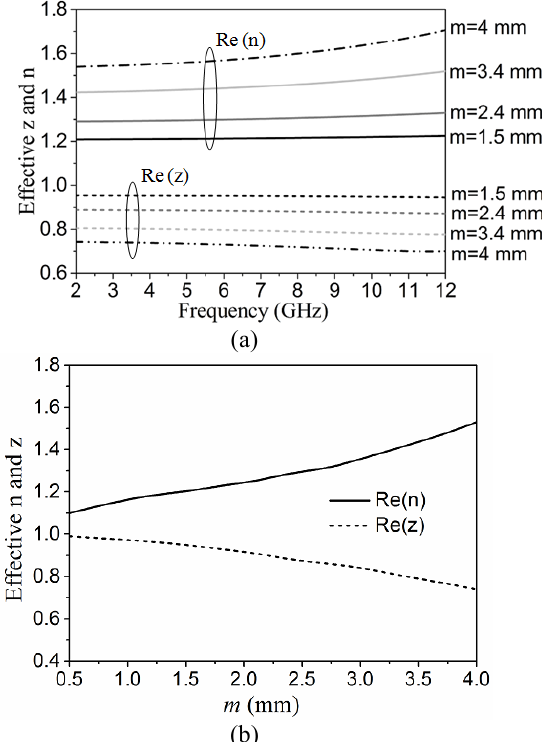
Figure 4: Retrieval results for the parallel line medium, (a) The extracted index and impedance for several values of m , (b) The relationship between the extracted refractive index ( n ) and wave impedance ( z ) on length m .